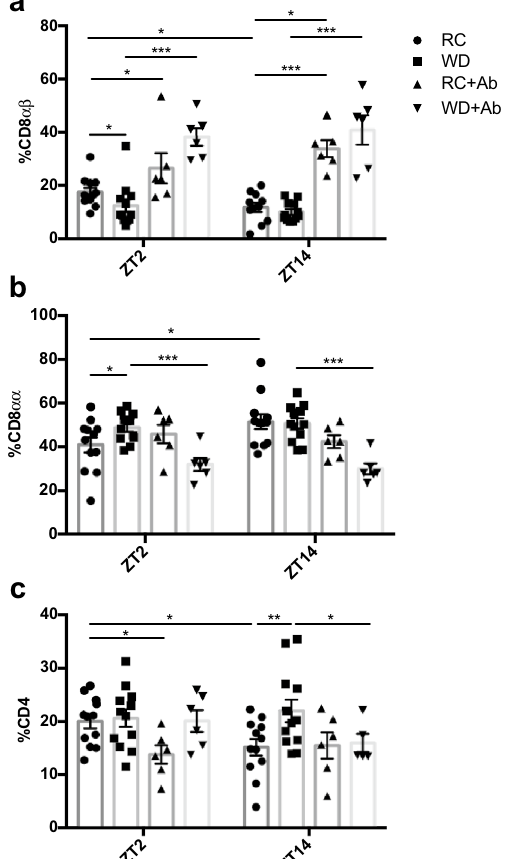
Figure 5. Time, diet, and microbial disruption alter proportions of SI IEL cell populations. Proportions of ( a ) CD8αβ + , ( b ) CD8αα + , and ( c ) CD4 + on TCRβ + cells acquired from the SI epithelium at ZT2 and ZT14 from RC- and WD-fed animals with and without AIMD. n = 3–6 male and 3–6 female mice. * p < 0.05 ** p < 0.01 *** p <